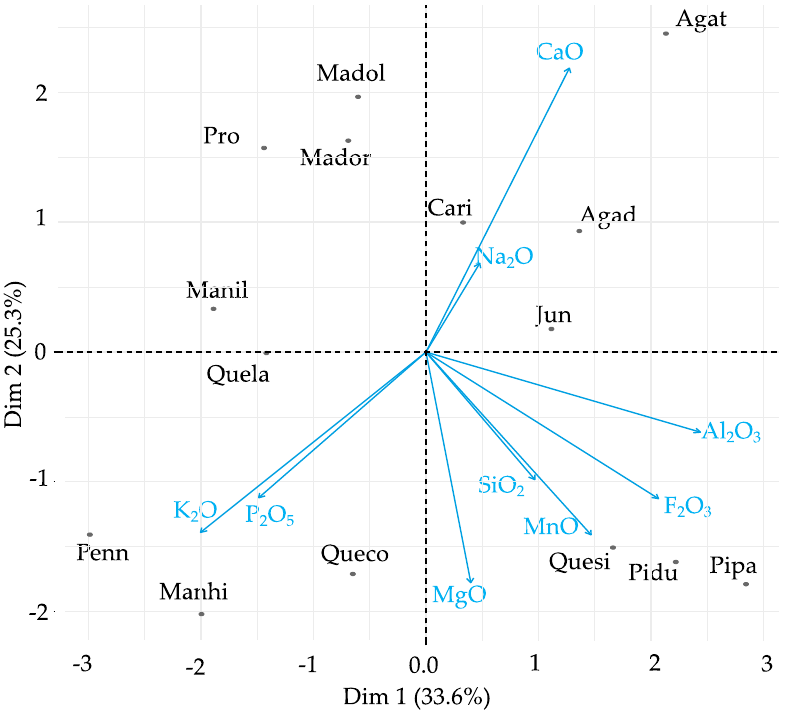
Figure 4. Principal component analysis at 550 °C. Blue lines show the vectors in the CP1 and CP2; the points represent the pellets sources evaluated.